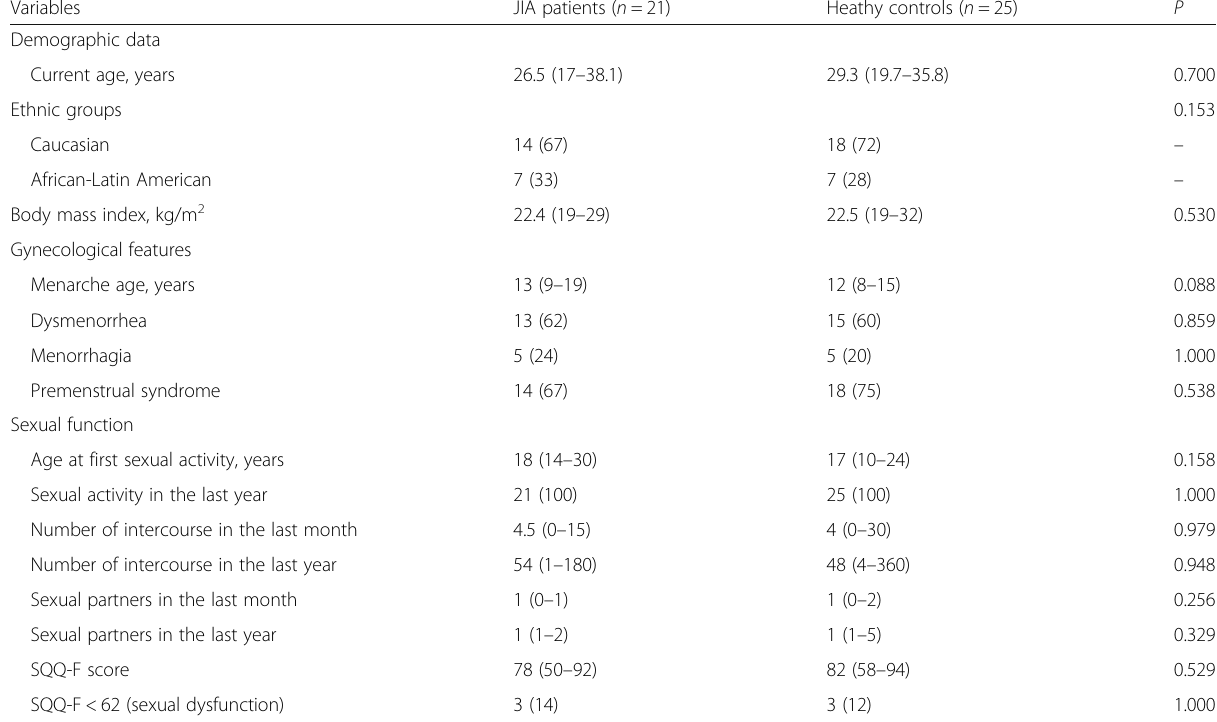
Table 1 Demographic data, gynecological features and sexual function in juvenile idiopathic arthritis (JIA) patients and healthy controls